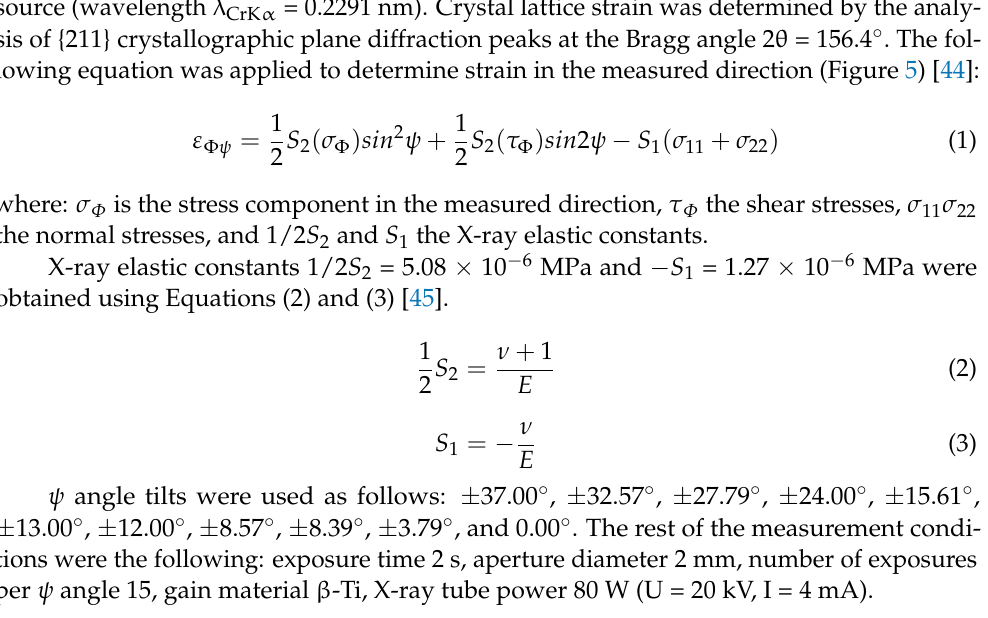
Table 2. Residual stresses for the X and Y axes of the LITECOR ® front side. Front Side Residual Stresses for X-Axes (MPa) Location